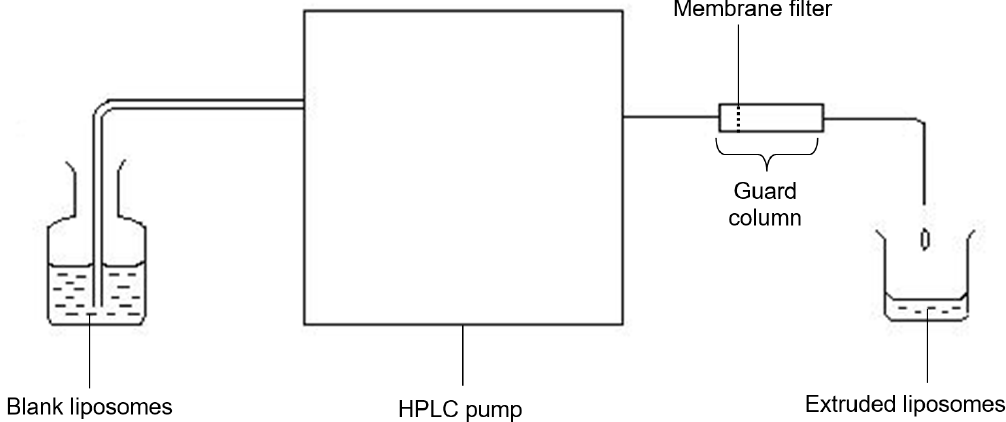
Figure 1. Assembly of instrument used for the extrusion process.